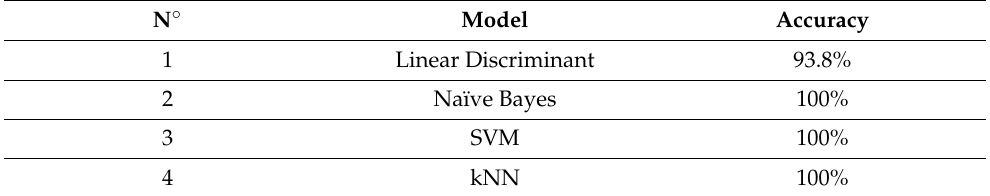
Table 1. Results of the classification of pesticide types and distilled water samples using pattern recognition and machine learning methods.